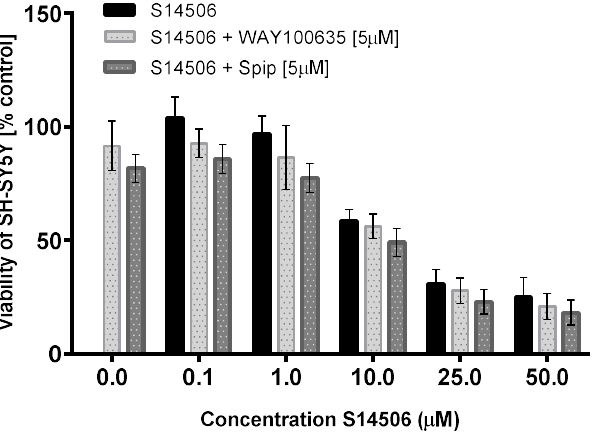
Figure 8. Cytotoxicity of S14506 on PC-3 cells in the presence of WAY100635 (5 µ M) and spiperone (5 µ M). * p < 0.05 vs. control.